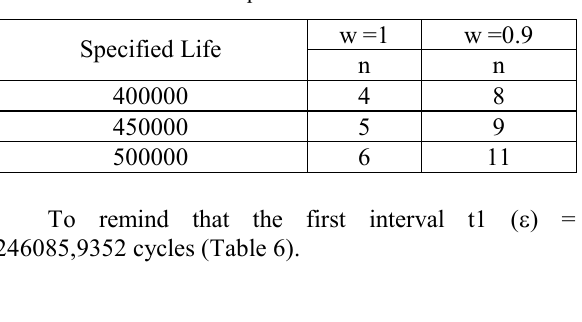
Table 7. Required number of inspections for